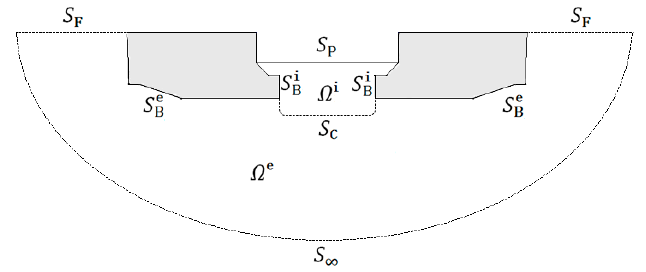
Figure 1. Water flow domains Ω i , Ω e and their boundaries around the transverse section of an SES. Figure 1. Water flow domains (cid:2007) (cid:2919) , (cid:2007) (cid:2915) and their boundaries around the transverse section of an SES. The outer domain Ω e is surrounded by free surface S F , outer wetted surface S e The outer domain (cid:2007) (cid:2915) is surrounded by free surface (cid:1845) (cid:2890) , outer wetted surface (cid:1845) (cid:2886)(cid:2915) , splitter (cid:1845) (cid:2887) , and boundary at infinity S ∞ . The inner domain Ω i is enclosed by interface S P , inner wetted surface S i splitter S C